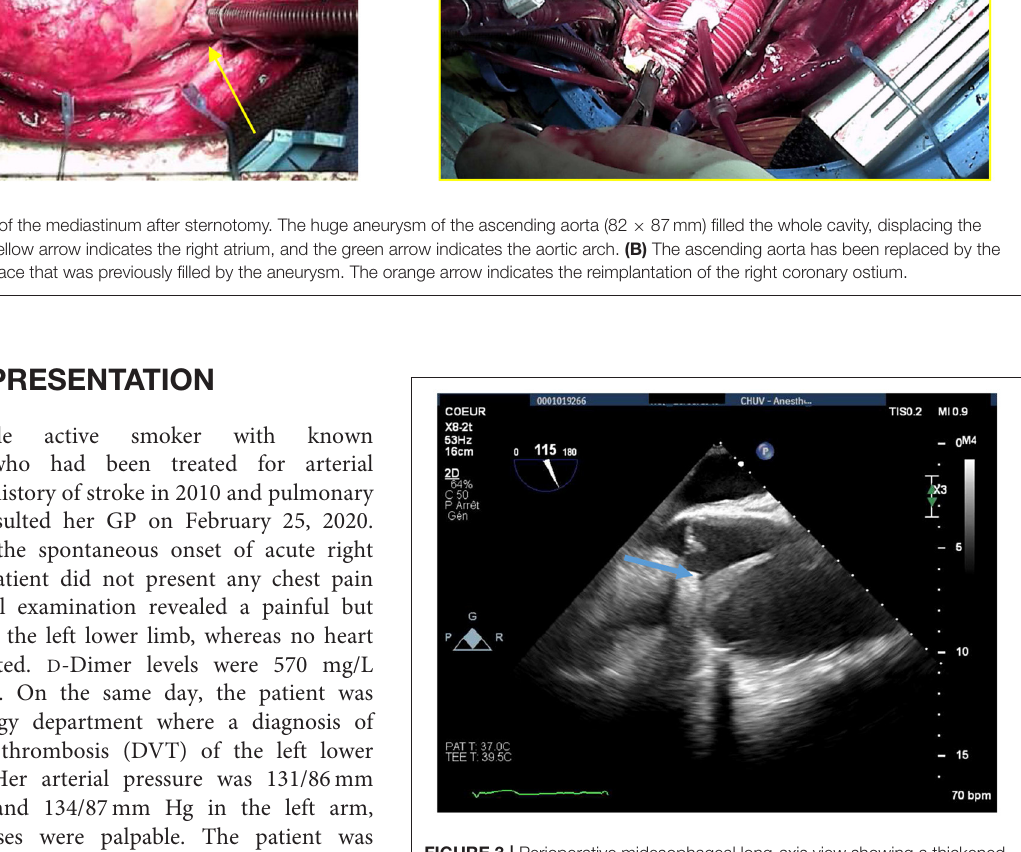
FIGURE 3 | Perioperative midesophageal long-axis view showing a thickened (5mm) dissection flap localized in the proximal ascending aorta, immediately after the origin of the right coronary artery (blue arrow). The maximal diameter of the ascending aorta was